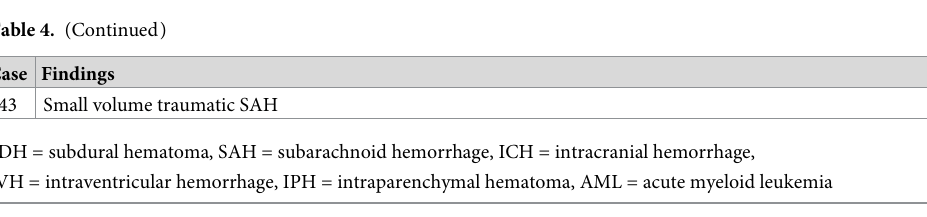
PLOS ONE | https://doi.org/10.1371/journal.pone.0281900 March 13,